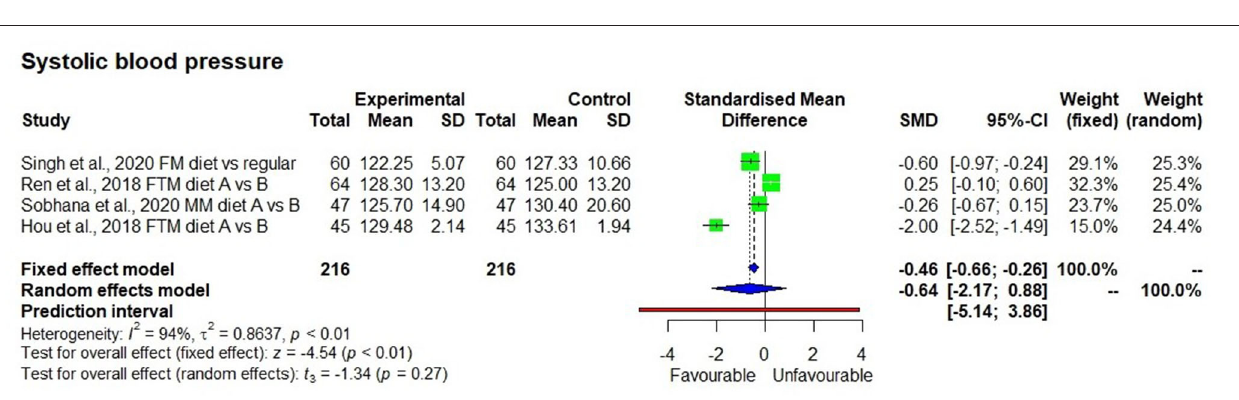
FIGURE 9 | Effect of consuming millets on systolic blood pressure of the participants (pre- vs. post-treatment or intervention vs. control diet).